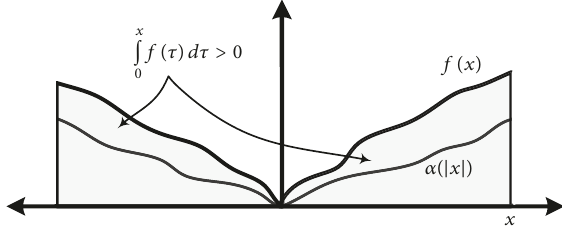
Figure 5: Graphical interpretation of Lemma